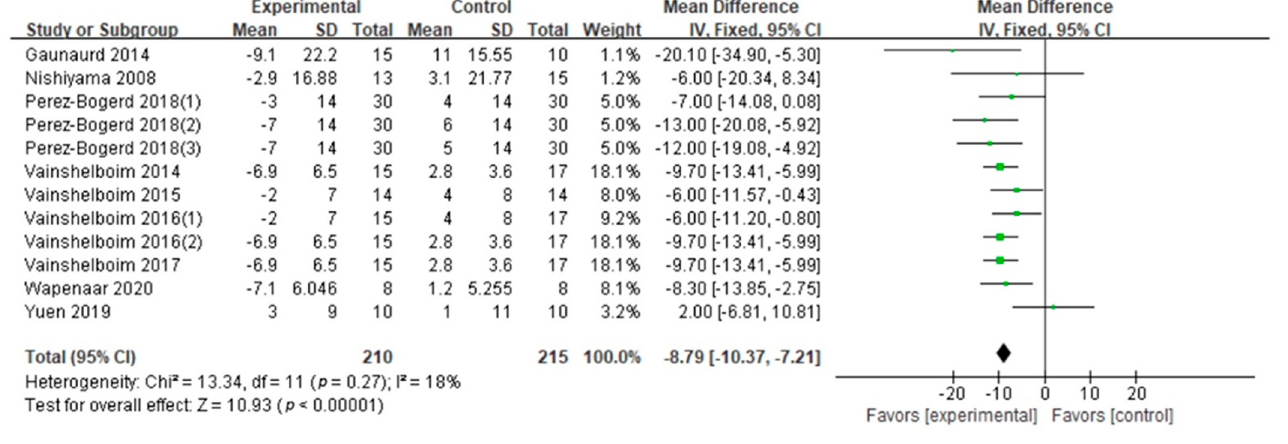
Figure 7. SGRQ. Figure 7.